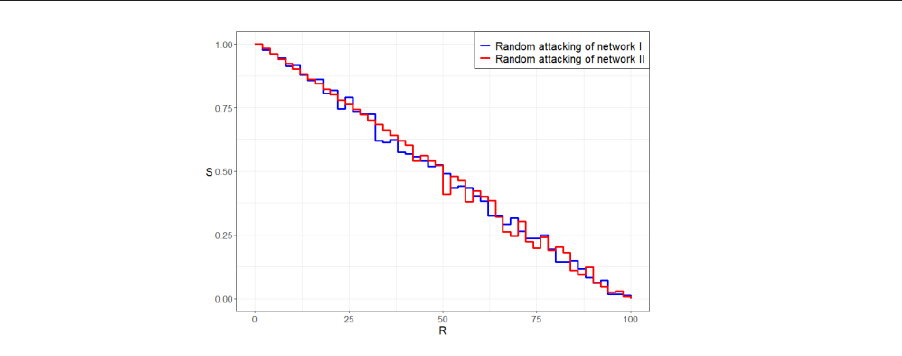
Fig. 6. The relative results of maximum connected subgraph(random attacking).